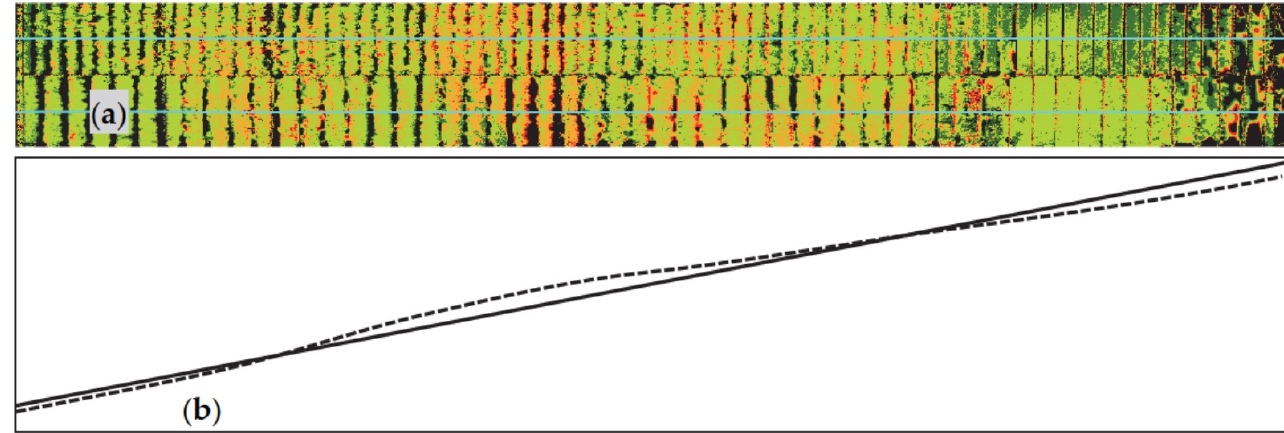
Figure 22. ( a ) Position of the longitudinal axes in the plan view of the WSB armoring at the testing chute; ( b ) Conceptual scheme of the longitudinal profiles of the initial (continuous) and final (dis- continuous) states of the WSB armouring in Test Session 1.